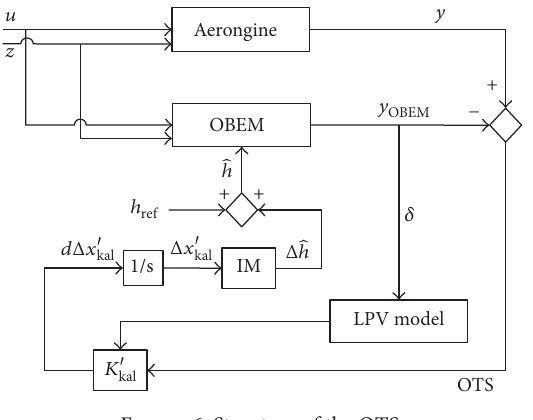
Figure 6: Structure of the OTS.